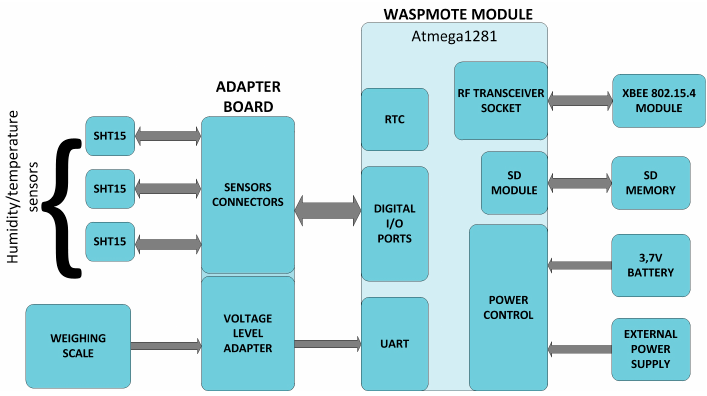
Figure 9. UcoBee block diagram.